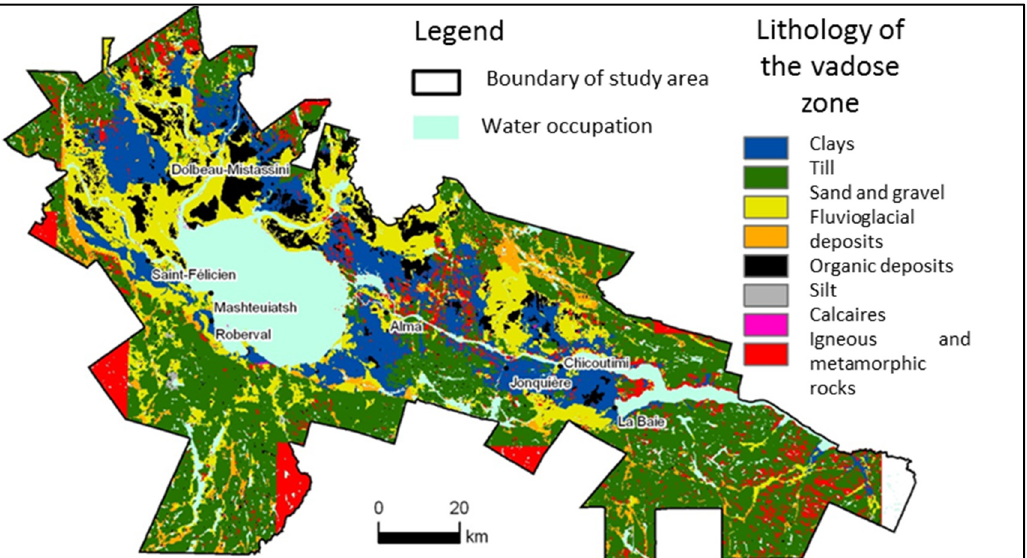
Figure 2. Mapped surficial geology units in the Saguenay-Lac-Saint-Jean (SLSJ) region (modified from